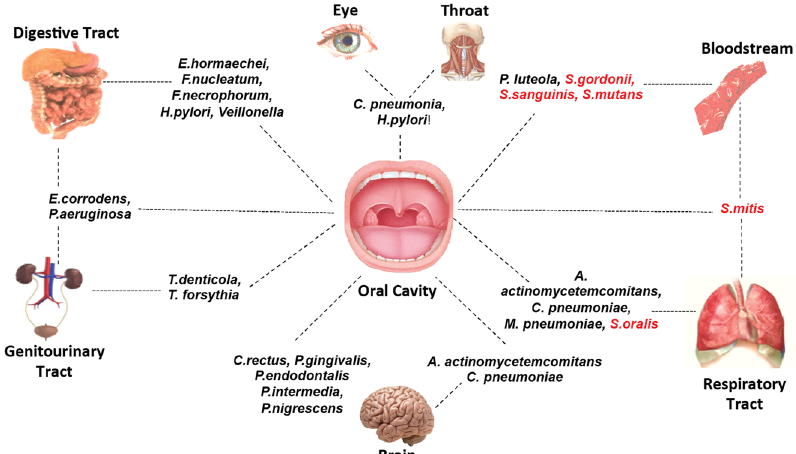
Fig. 3 The tissue localization of the 23 oral commensal bacteria associated with atherosclerotic plaque samples from CAD patients. Sixteen of the 23 atherosclerotic plaque-associated bacteria were not unique to atherosclerotic plaque samples and are present in multiple non-cardiac organs (gram-negative microbes are in red )